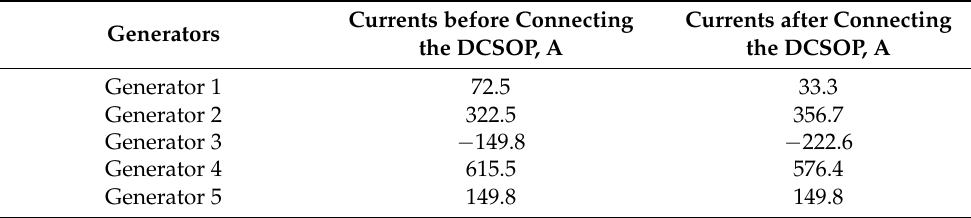
Table 3. Currents from the DC microgrid generators before/after connecting the DCSOP.